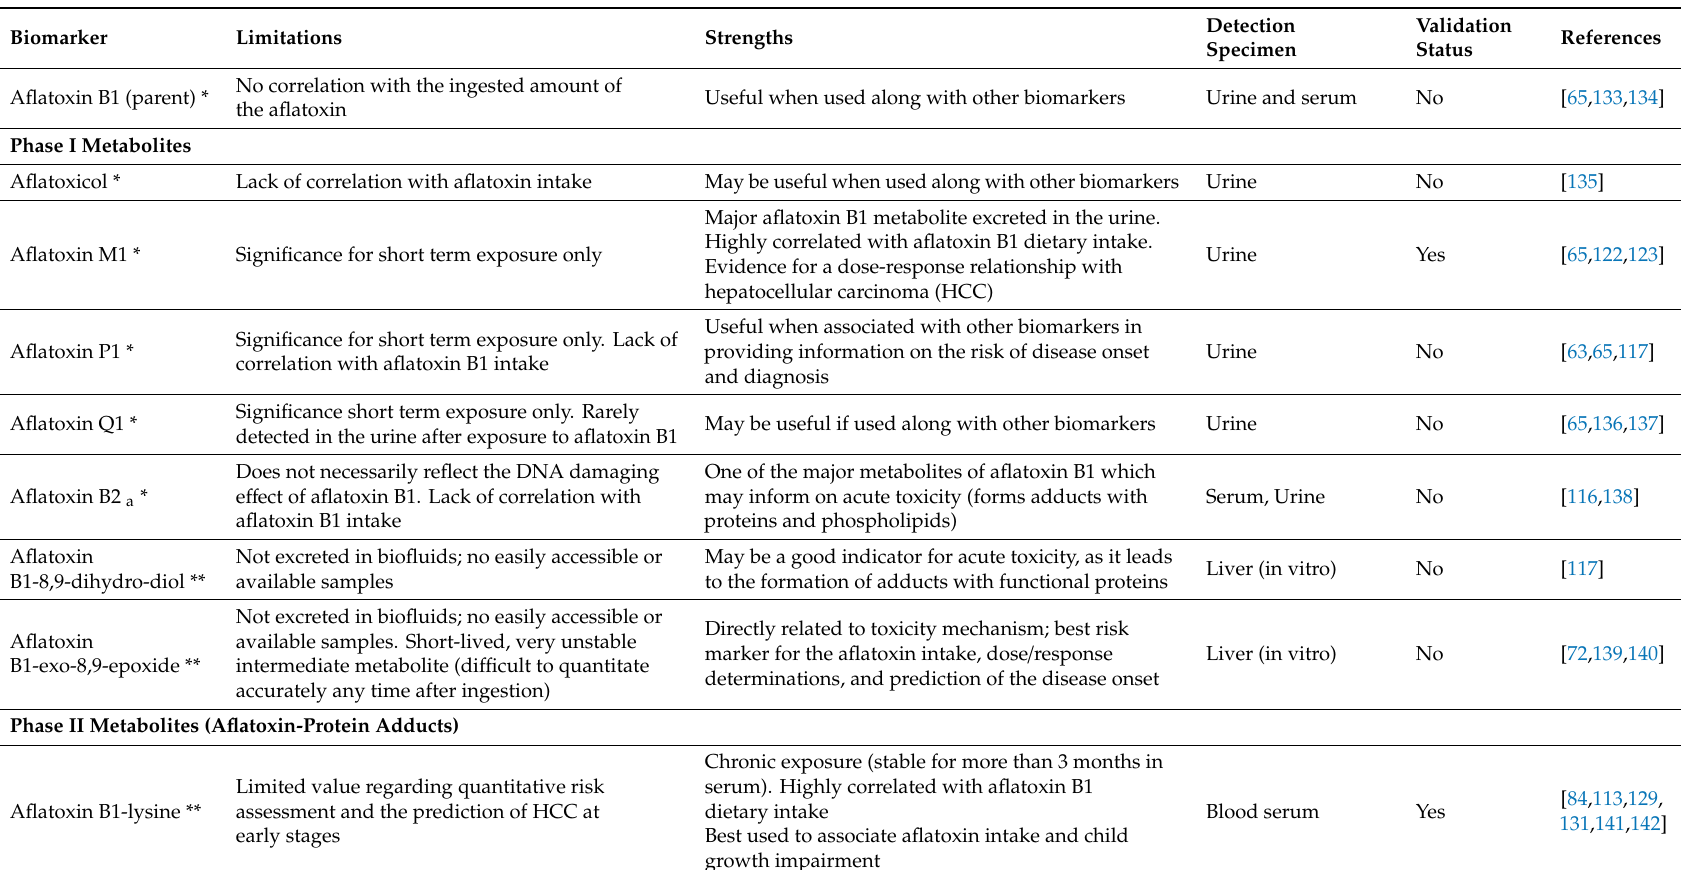
Table 3. Biomarkers used to assess exposure or risk posed by aflatoxin B1 in humans, limitations and